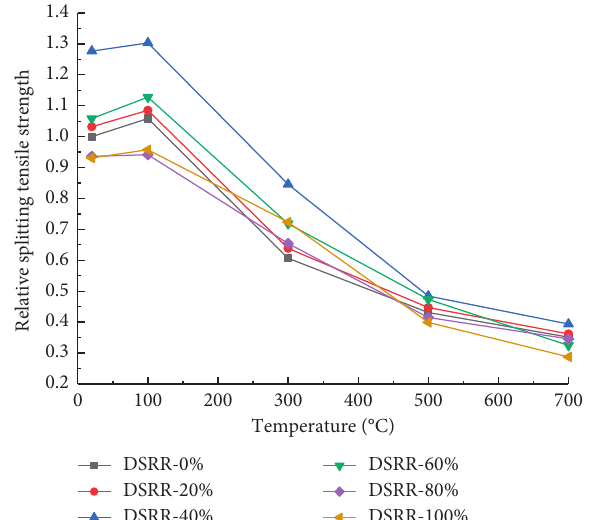
Figure 13: Relation between relative splitting tensile strength and temperature.